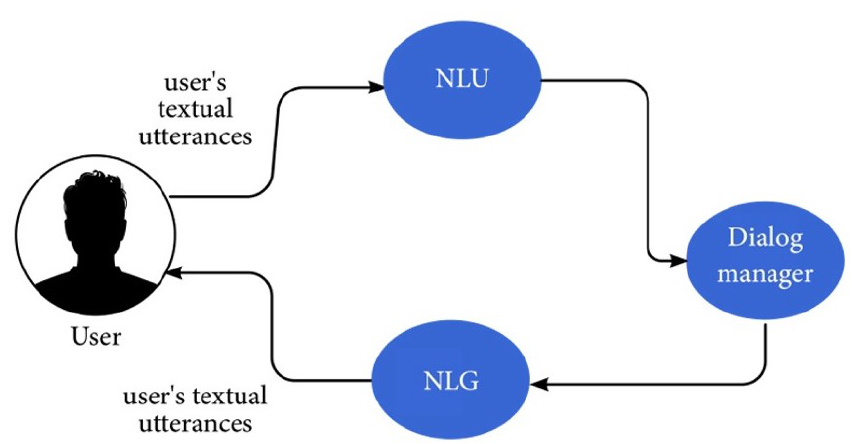
Figure 4. The textual components of